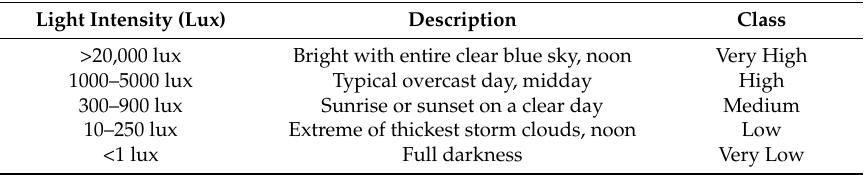
Table 7. Classes of light